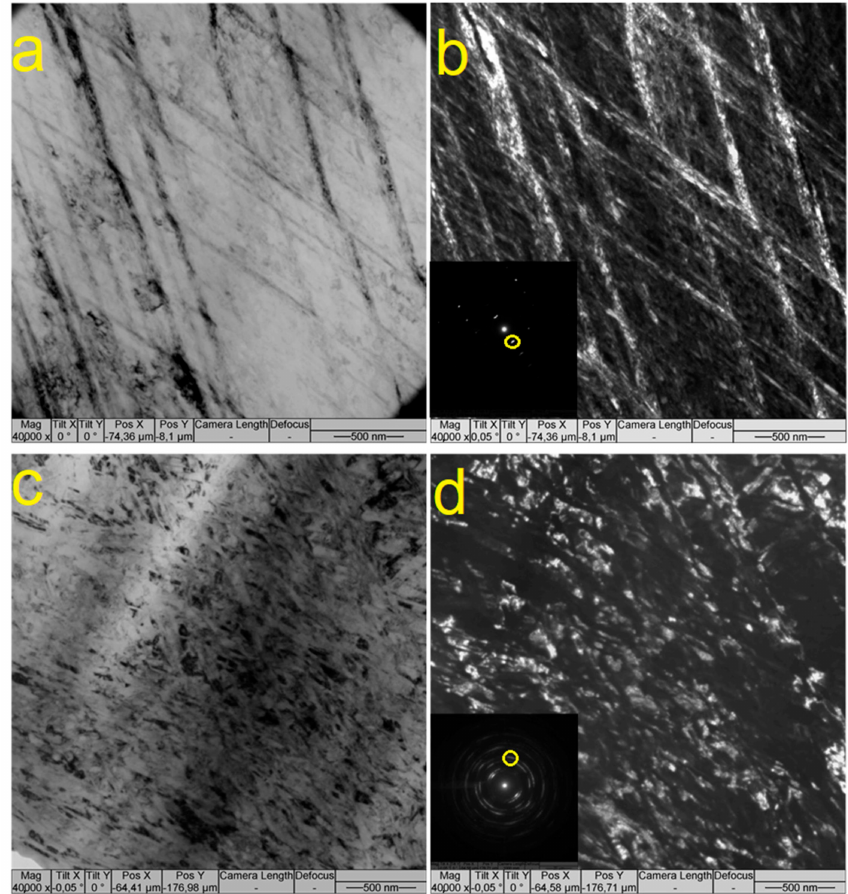
Figure 14. TEM bright and dark field images of twin systems formed in section 4-2 ( a , b ) and submicron sized microstructures formed in sample 4-1 ( c , d ) after tensile test on sample 4. The dark field images were obtained using the twin reflections shown in circles in corresponding SAED